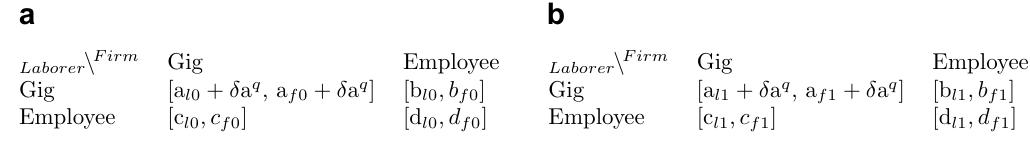
Figure 5: High Gig Payo↵, Matrix Operation Figure 11. High gig payoff, matrix operation. ( a ) High gig payoff, n = 0; ( b ) high gig payoff, n = 1.